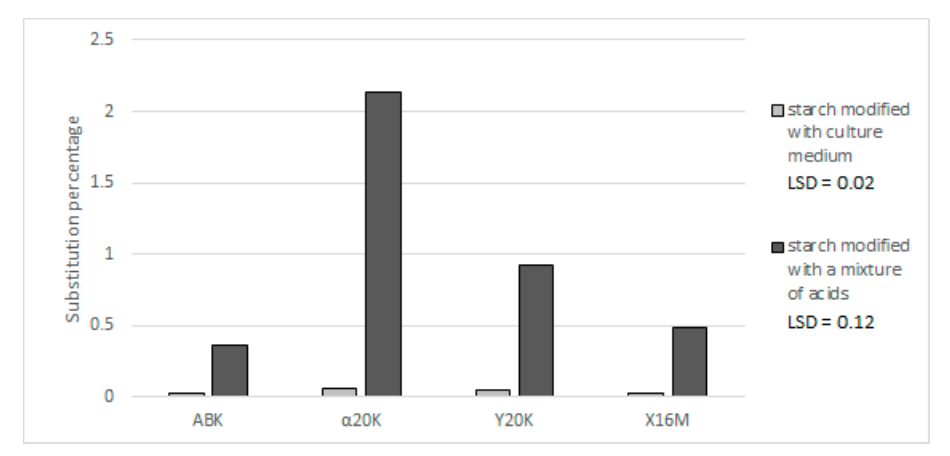
Figure 3. Effect of applied post-culture medium or a synthetic mixture of acids on the percentage of substitution of potato starch preparations with α -ketoglutaric acid.